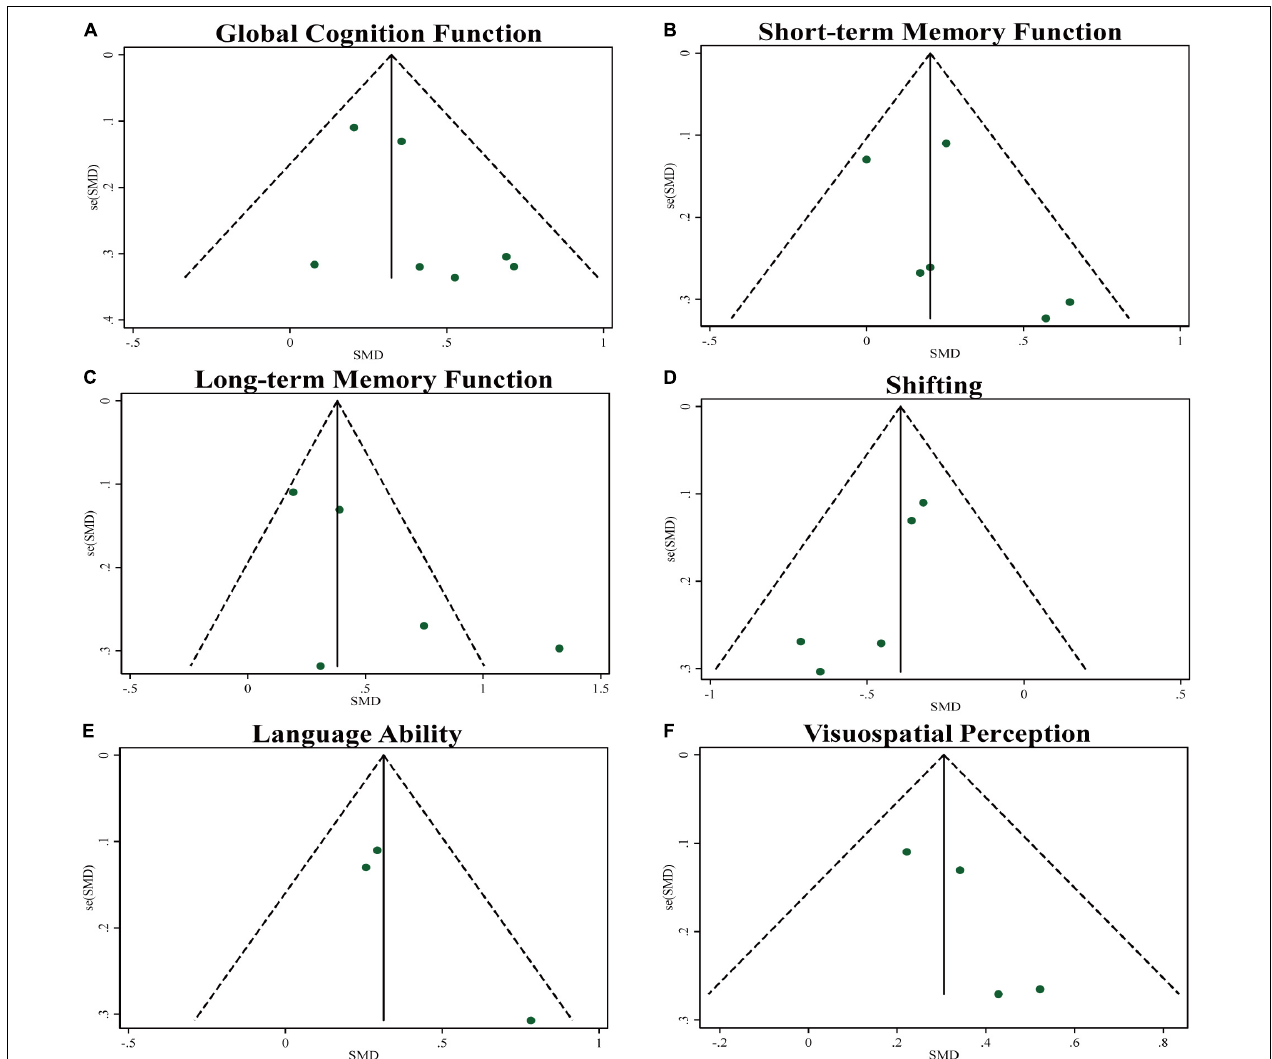
FIGURE 2 | Funnel plots of publication bias for global cognitive function and specific cognitive domains.